Question: What style of plot is this figure drawn as?
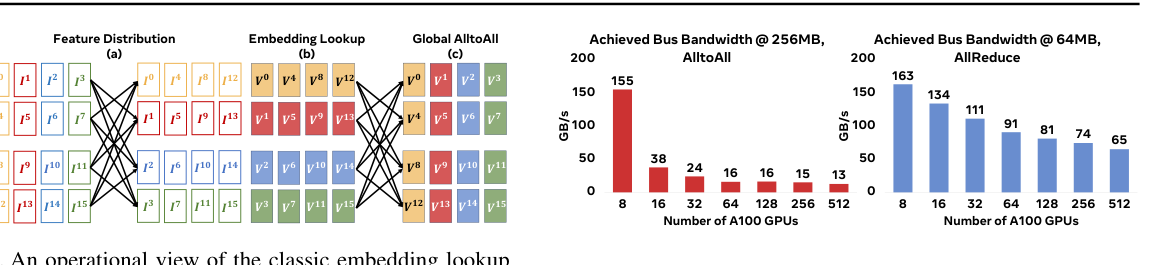
Answer: line